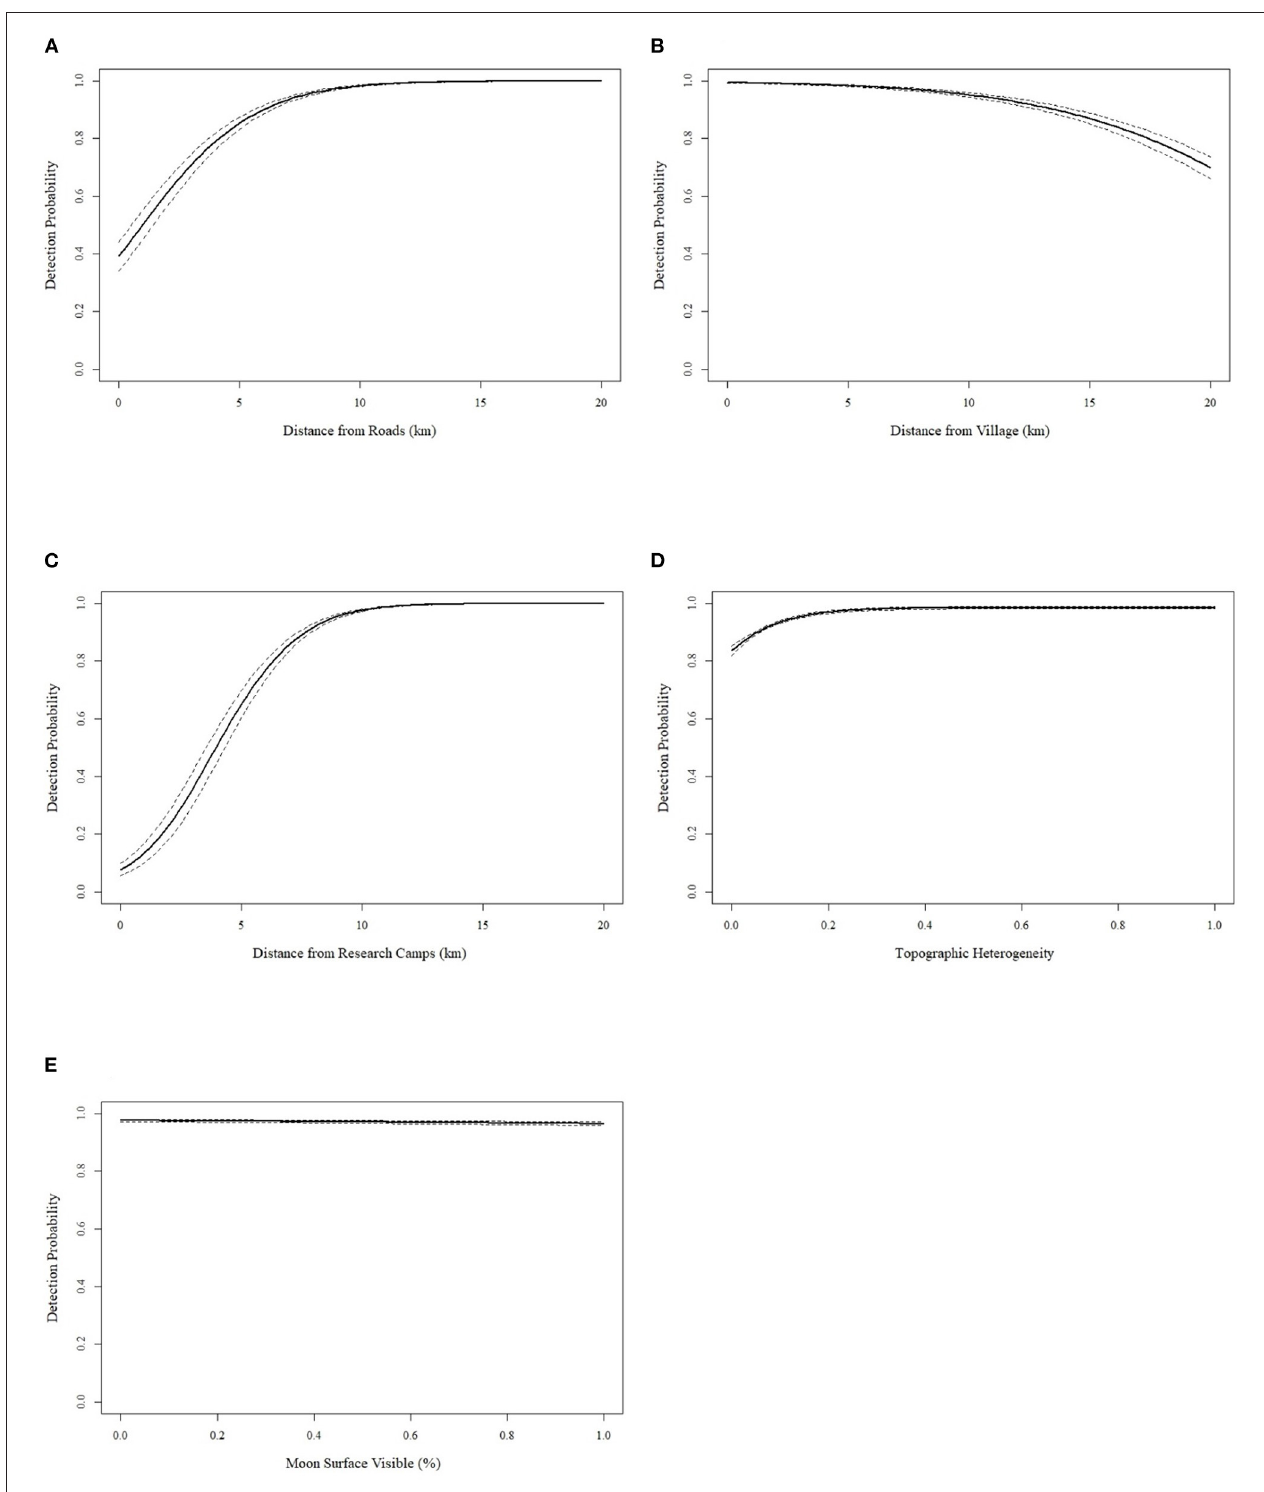
FIGURE 3 | Probability ( ± 95%) of hunting detection as a function of distance to road (A) , distance to village (B) , distance to nearest research camp (C) , topographic heterogeneity (D) and moon intensity (E) .